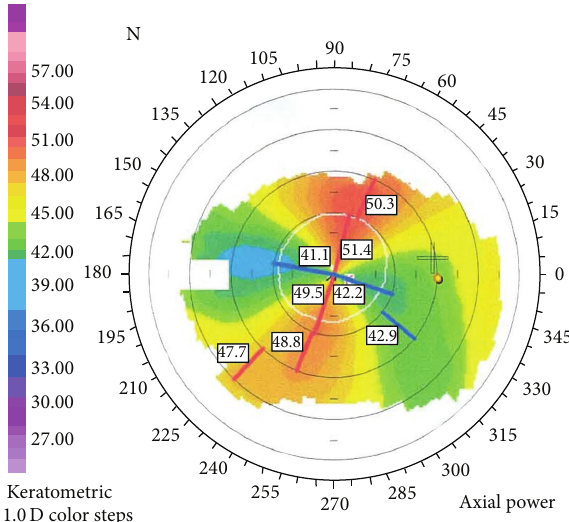
Figure 6: Orbscan photograph of left eye demonstrating irregular astigmatism and vertical